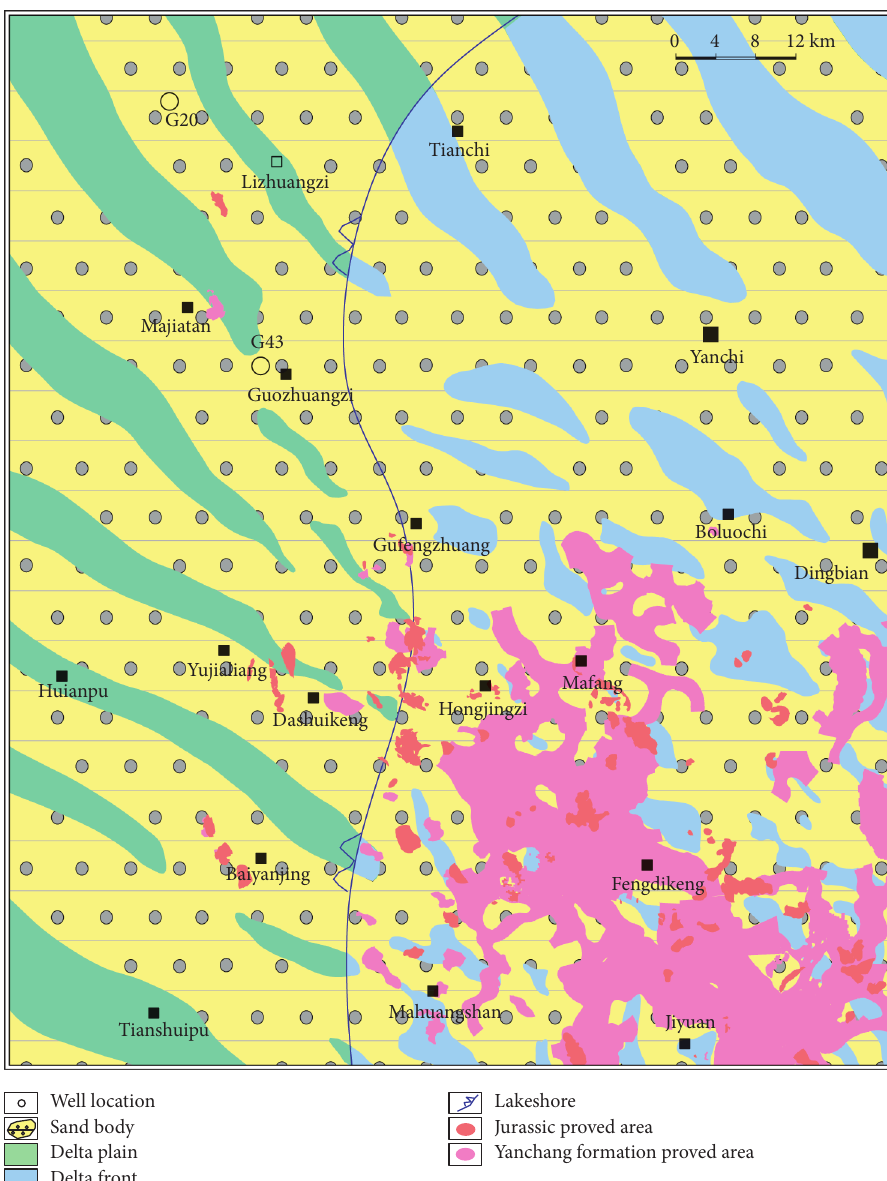
Figure 7: Sedimentary facies map of the Chang 8 member of the Yanchang formation in the northwest Ordos